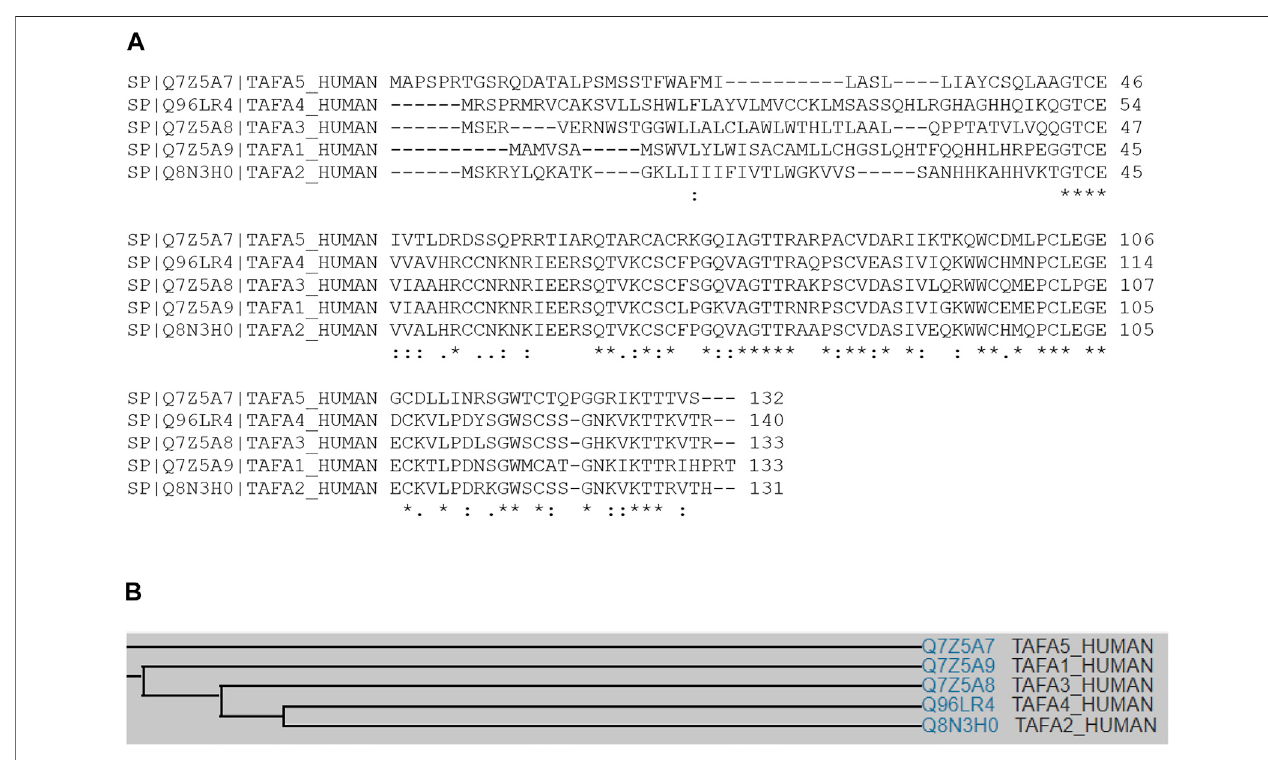
FIGURE 2 | Multiple sequence alignment of TAFA4 among family members. (A) Multiple sequence analysis demonstrates that human TAFA1, TAFA2, TAFA3, TAFA4, and TAFA5 shares signi fi cant degree of amino acid sequence identity, especially at their C terminal regions. (B) Family tree of human TAFA1, TAFA2, TAFA3, TAFA4, and